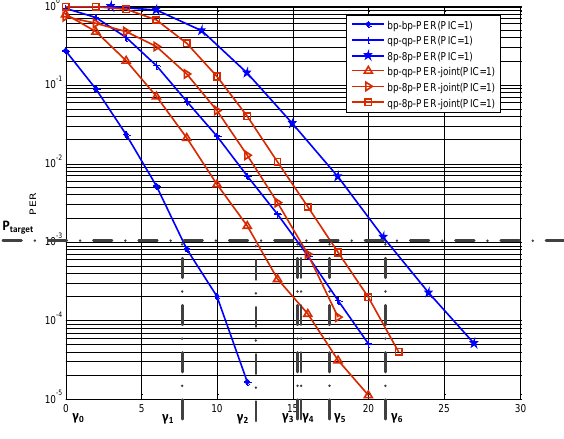
Fig.3 End-to-end performance comparison of asymmetric transmission between JCM and DF-XOR [2] schemes